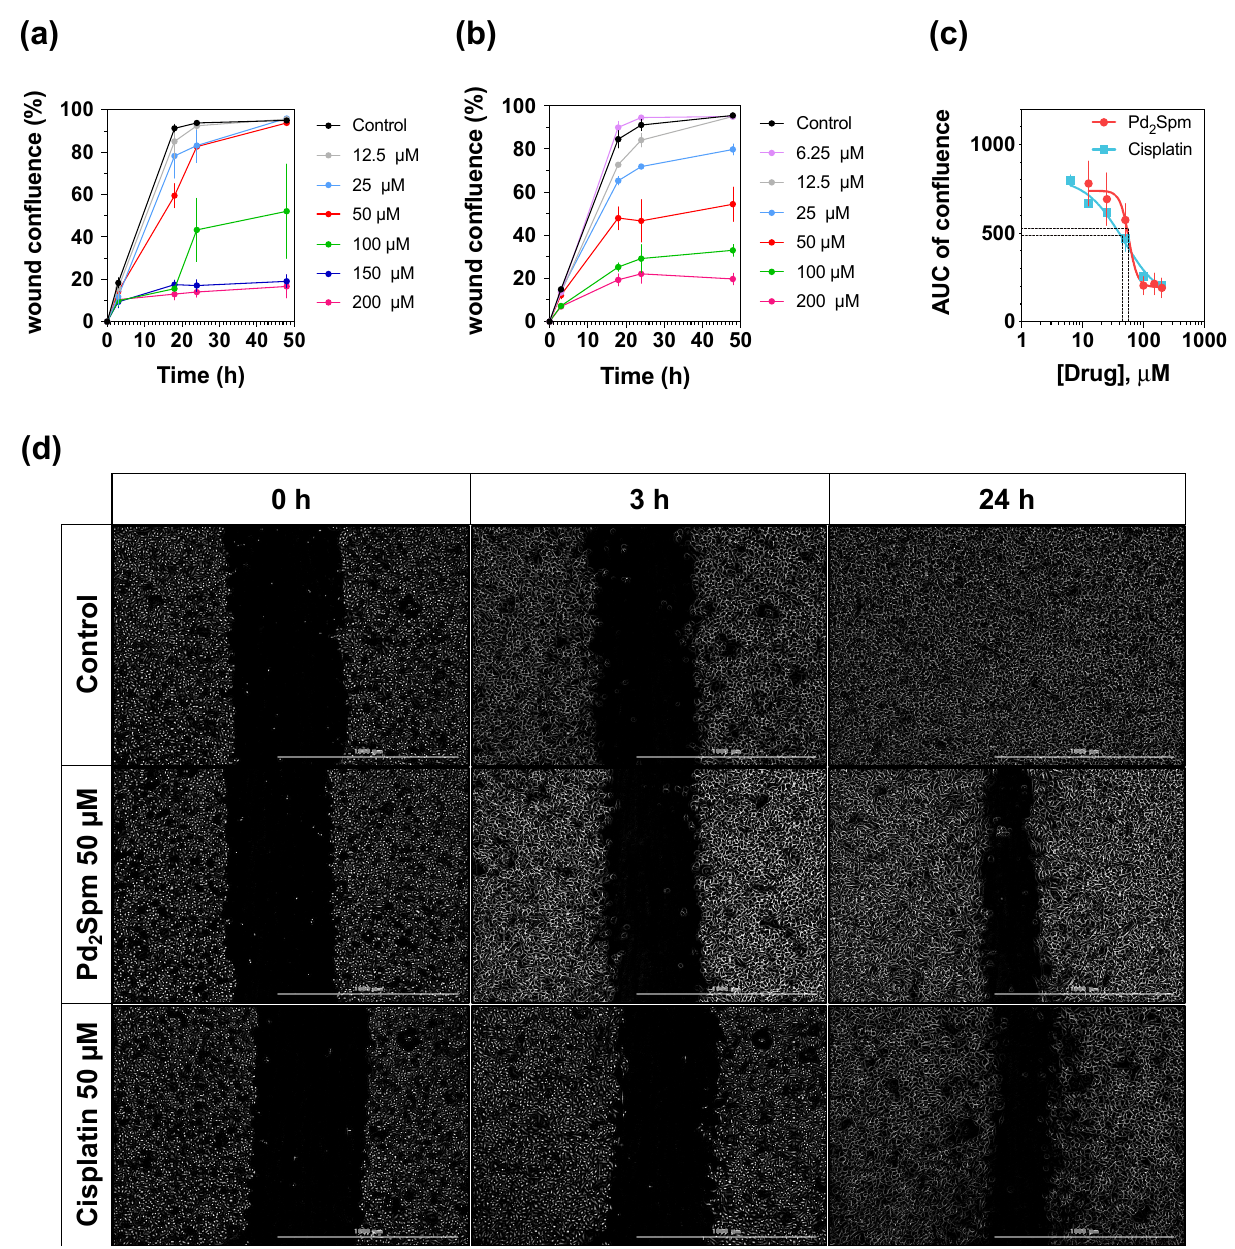
Figure 2. Effects of Pd 2 Spm and cisplatin on migration of MDA-MB-231 cells using scratch/wound healing assay. ( a ) Dose-dependent effect of Pd 2 Spm on migration of MDA-MB-231 cells expressed as wound confluence for tested Pd 2 Spm concentrations. ( b ) Dose-dependent effect of cisplatin on migration of MDA-MB-231 cells expressed as wound confluence for tested cisplatin concentrations. ( c ) Dose–response curve obtained from measuring the area under confluence curve (AUC) between 0 and 18 h of exposure to Pd 2 Spm or cisplatin. ( d ) Representative images from 5 independent exper- iments showing effects of 0 µM (control) and 50 µM of Pd 2 Spm or cisplatin on cell migration at 0, 3 and 24 h. Scale bar = 1000 µm. Data are expressed as mean ± SEM, n = 5. Data points with no visible error bars have errors smaller than the size of the symbol.